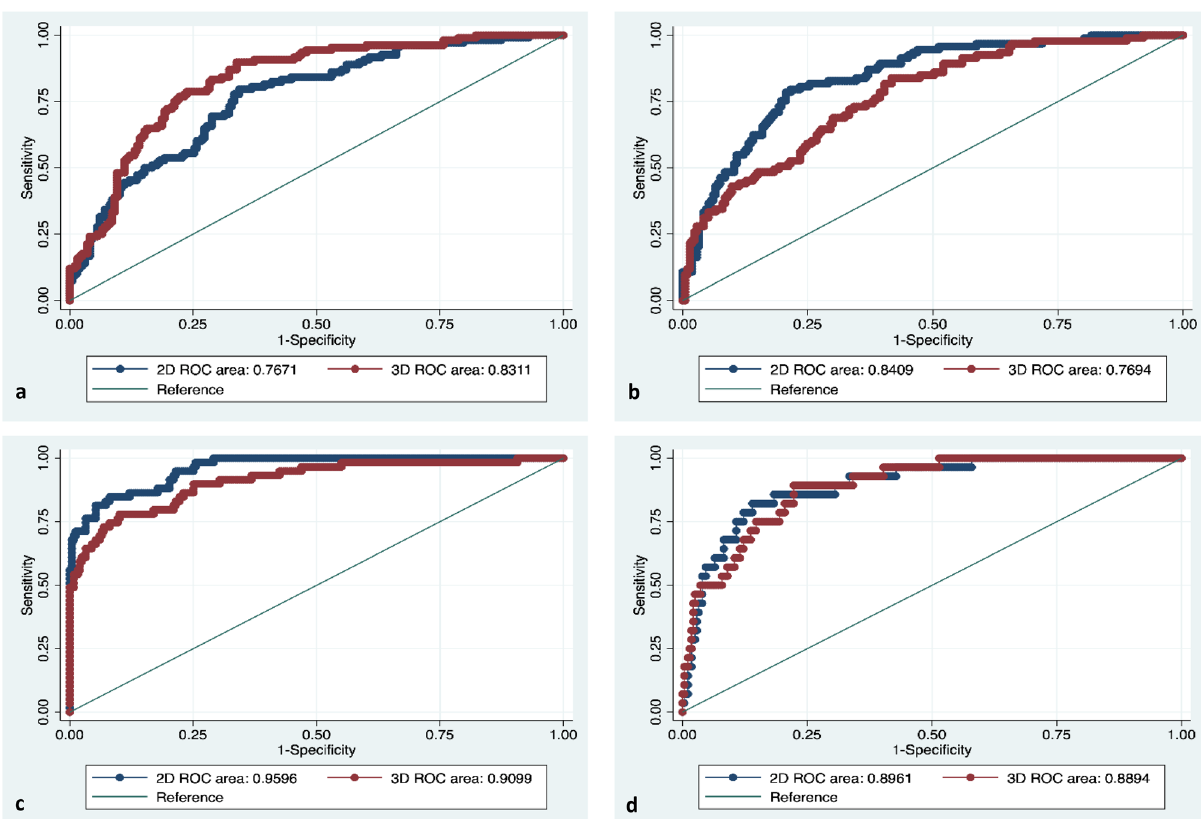
Figure 2. ROC curves of the testing subset for prediction of different etiologies of liver cirrhosis. Prediction of different etiologies of liver cirrhosis using one-vs-all multiclass logistic regression comparison between 2D- and 3D-extracted features in the following subgroups: alcoholic cirrhosis ( a ), viral hepatitis ( b ), cholestatic liver disease ( c ), and nonalcoholic steatohepatitis (NASH)-associated cirrhosis ( d